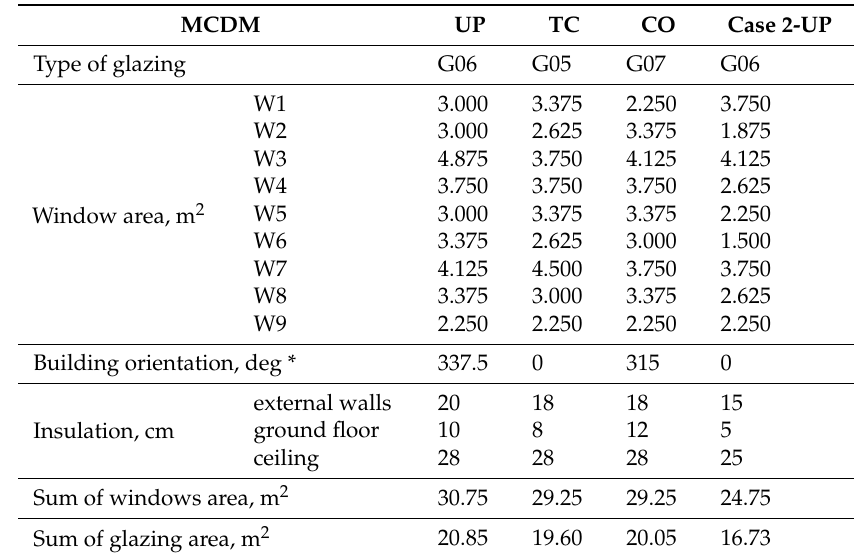
Table 9. Detailed results for cases 5 and